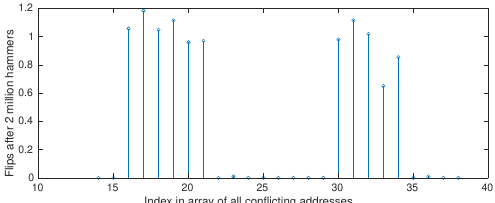
Figure 5: Distributions of total flips after 200 million to 2 billion hammers on i7-3770.